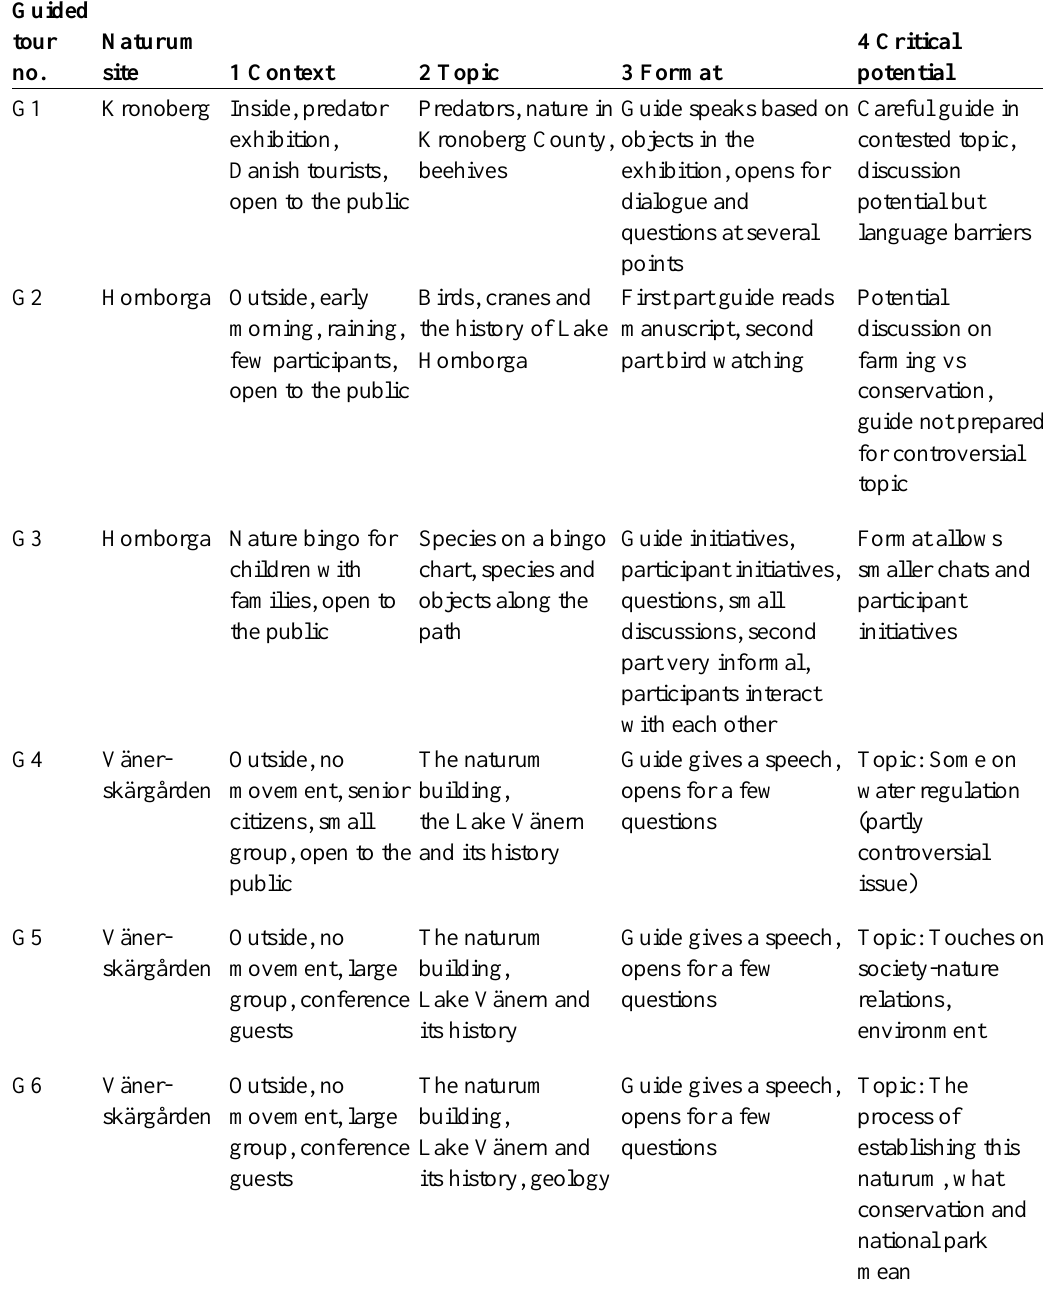
Table 3: The six sessions analyzed with examples from each of the analytical categories Guided tour